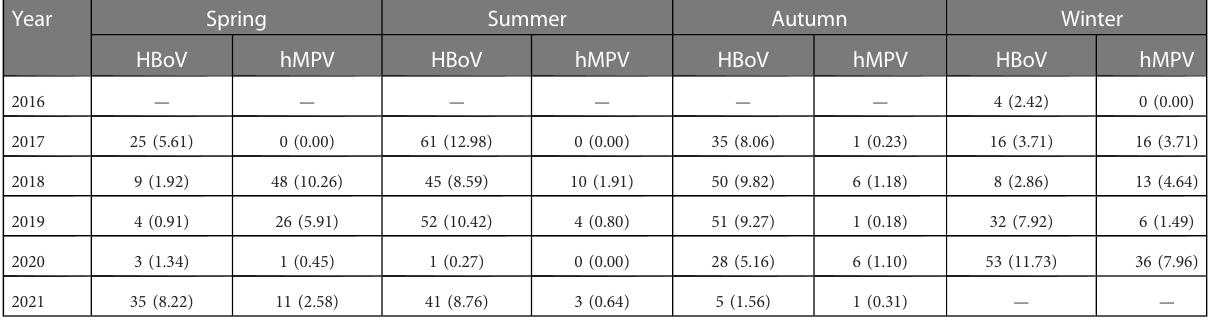
TABLE 3 Detection of HBoV and hMPV in different seasons in Suzhou over the 5-year study period [ n (%)]. Year Spring